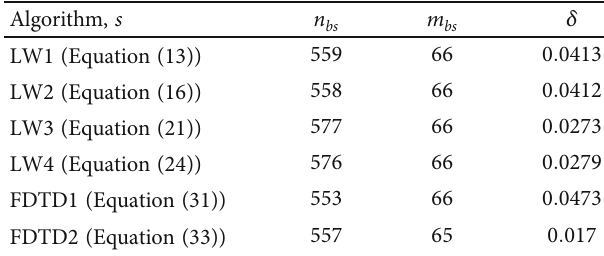
Figure 3: (a) Solution of (1) obtained from the FDTD algorithm (FDTD1: Equation (31)), displaying the spatial structure, m ∈ ½ 55, 70 (cid:2) , for time steps n = 510 (cross), n = 530 (plus sign), and n = 555 (point) exhibiting the evolution of the nonlinear wave and the advective instability. (b) Solution of (1) obtained from the conservative FDTD algorithm (FDTD2: Equation (33)), displaying the spatial structure for the same time steps. The plots illustrate the formation of the initial spike, as a result of the instability that disrupts the onward solution. FDTD1 and FDTD2 span the range of δ calculated in this paper. Table 2: Results for the fractional change of the numerical solution relative to the analytical solution for n = n bs and m = m bs